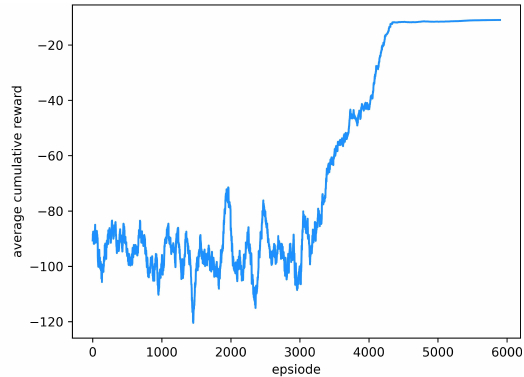
Figure 13. The average cumulative reward of follower 2 during